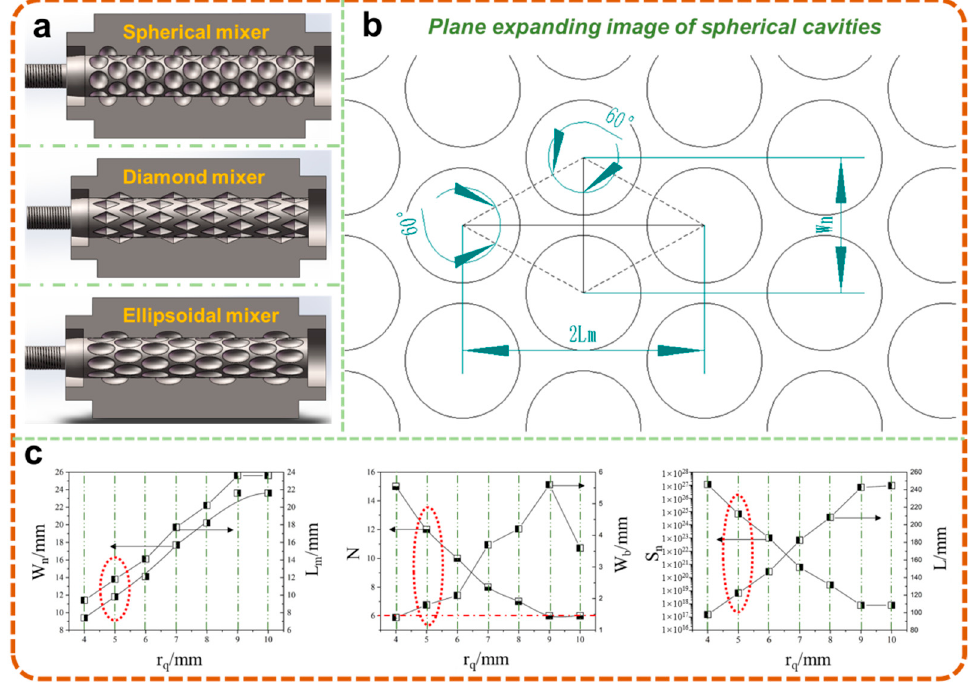
Figure 1. Mixers with different cavity shapes ( a ) and plane expanding image of spherical cavities ( b ), and parameters of spherical cavity mixer with different cavity sizes ( c ).